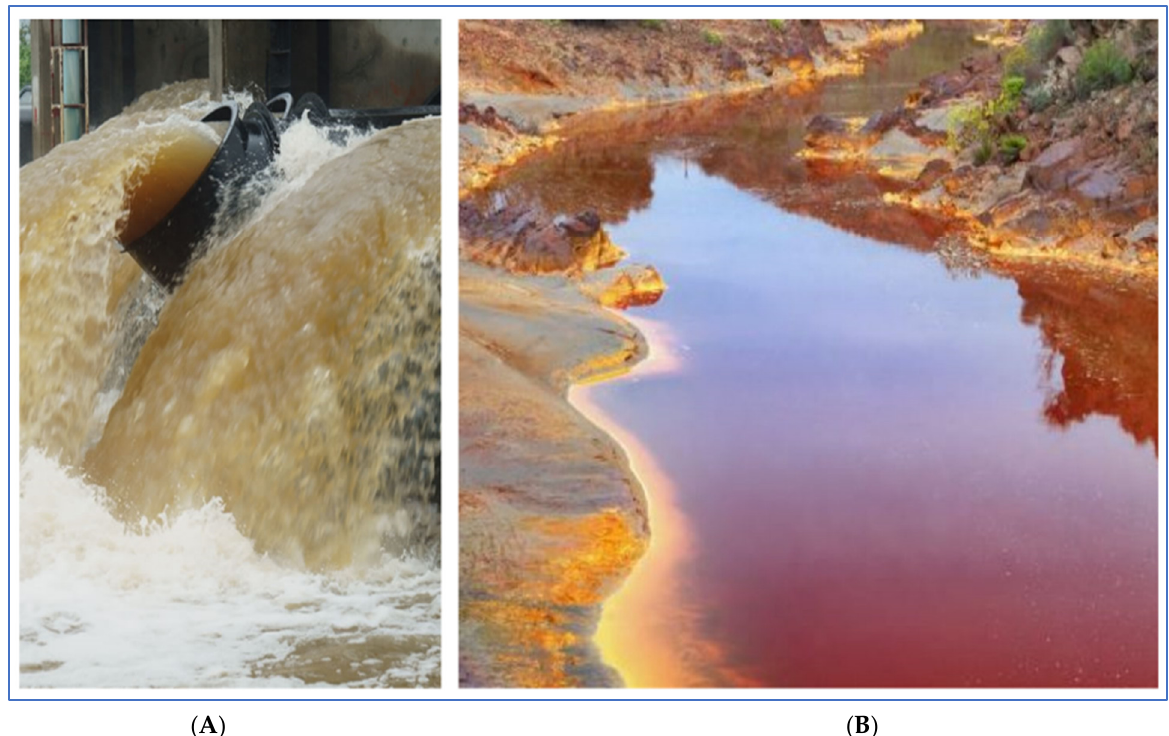
Figure 1. ( A ) Dye house discharge. ( B ) River quality affected by dyestuffs.